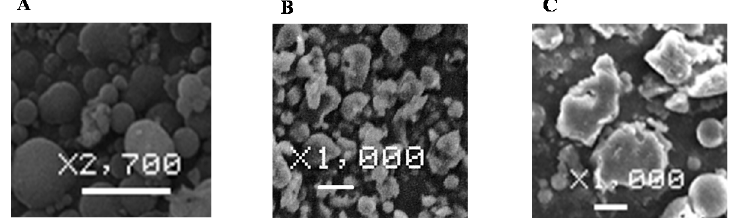
Figure 1. Scanning electron micrographs of ( A ) ES-MP; ( B ) Ch-MP and ( C ) Ch-MP/ES. The length of the white bar = 5 µm.